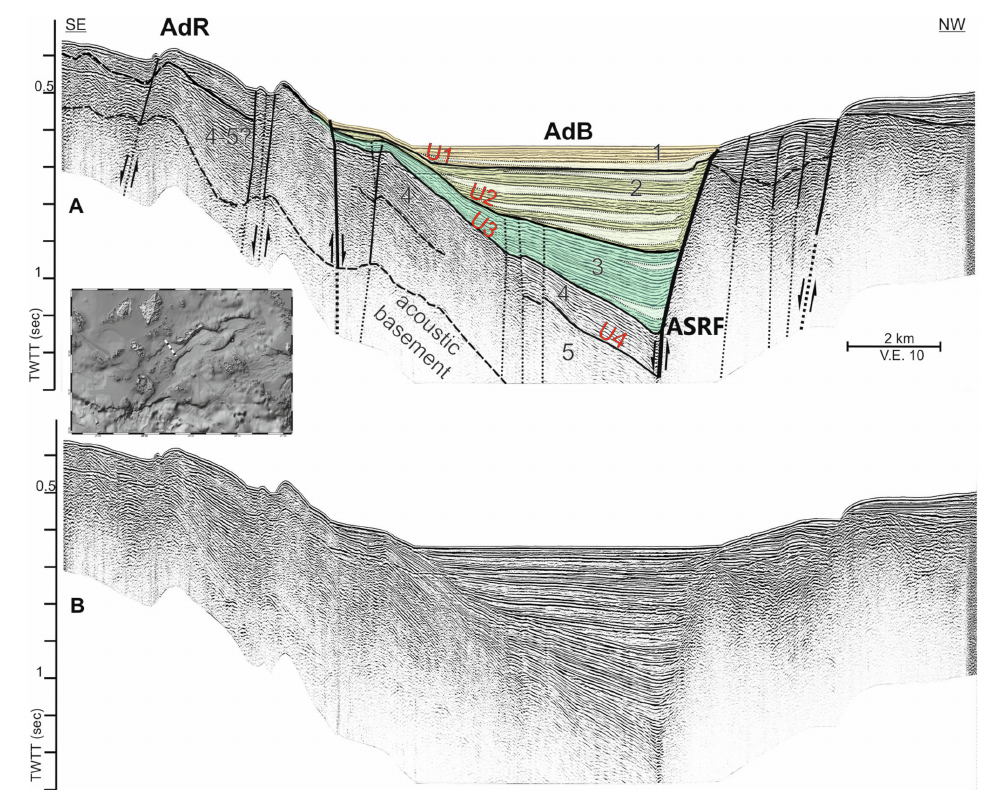
Figure 5. Airgun 40 ci seismic profile across the eastern part of Anydros Basin (AdB). AdR: Anydros Ridge, ASRF: Amorgos South Relay Fault. Terminology and symbols as in Figure